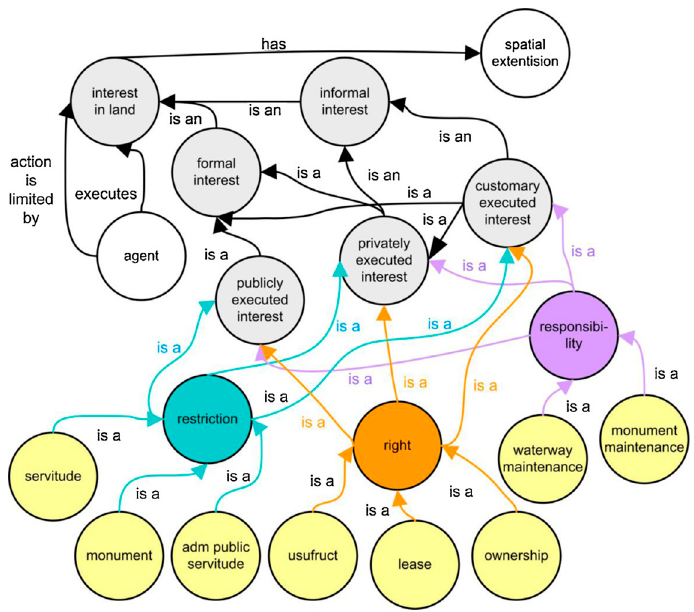
Figure 3. Ontology diagram showing land use relations, exemplified with RRRs listed in LADM Annex J of ISO 19152:2012 [68].